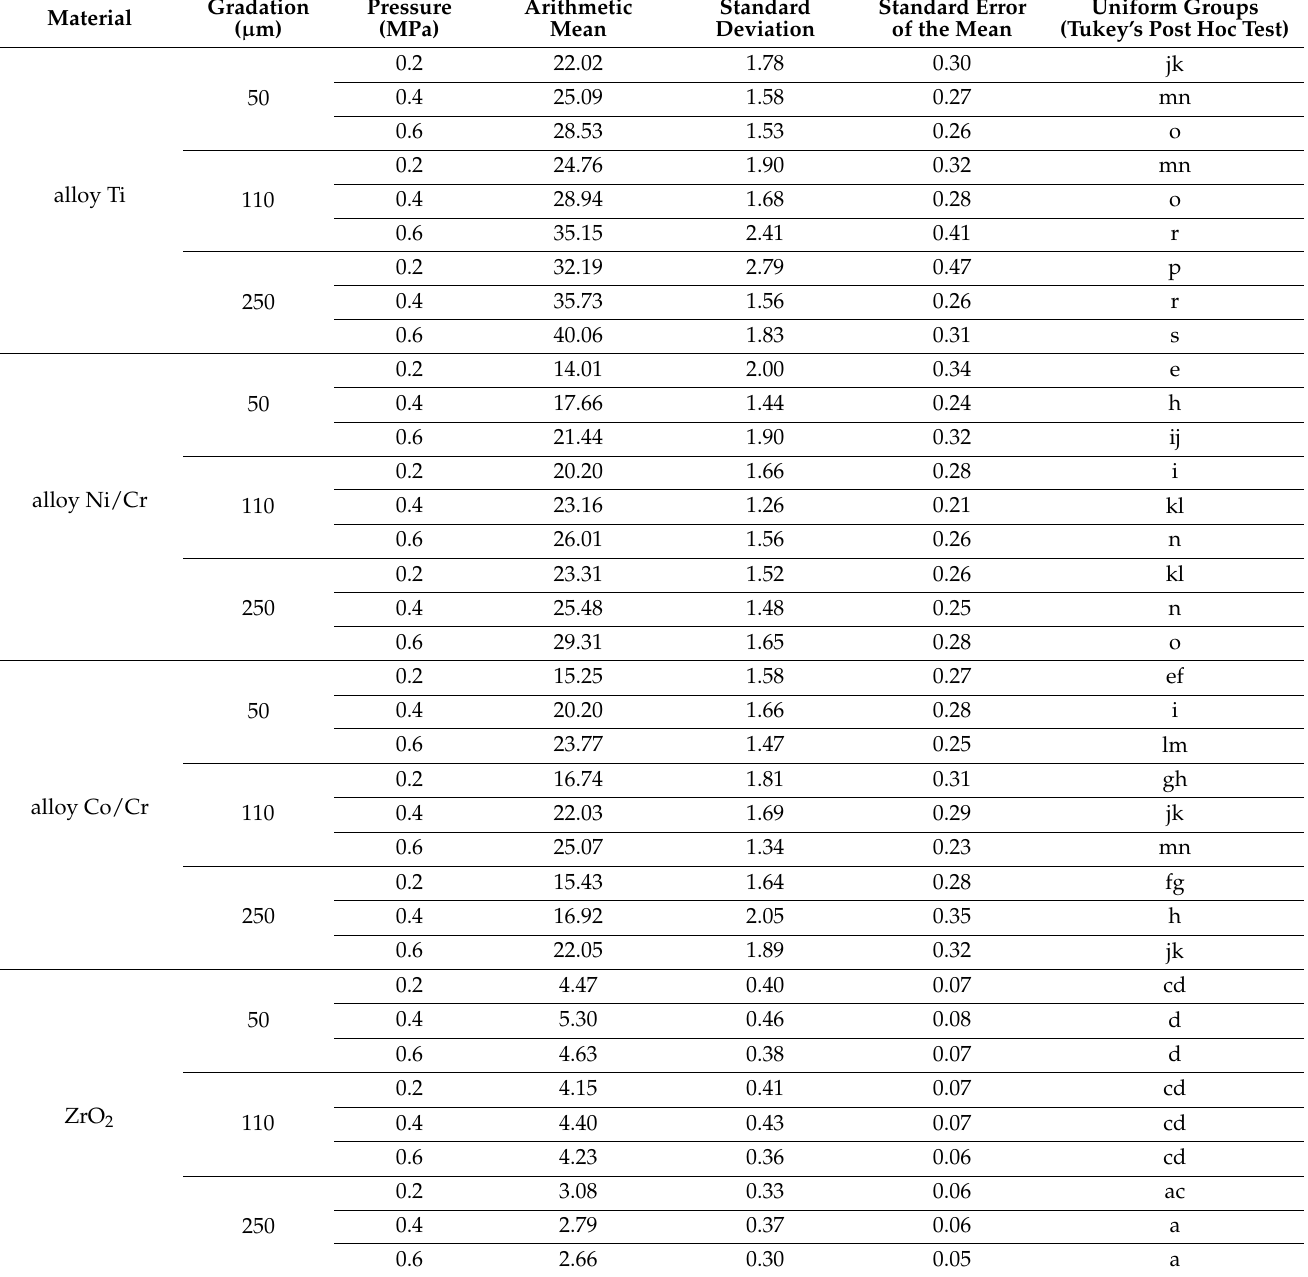
Table 2. Descriptive statistics of the amount of SiC embedded abrasive according to material and airborne-particle abrasion